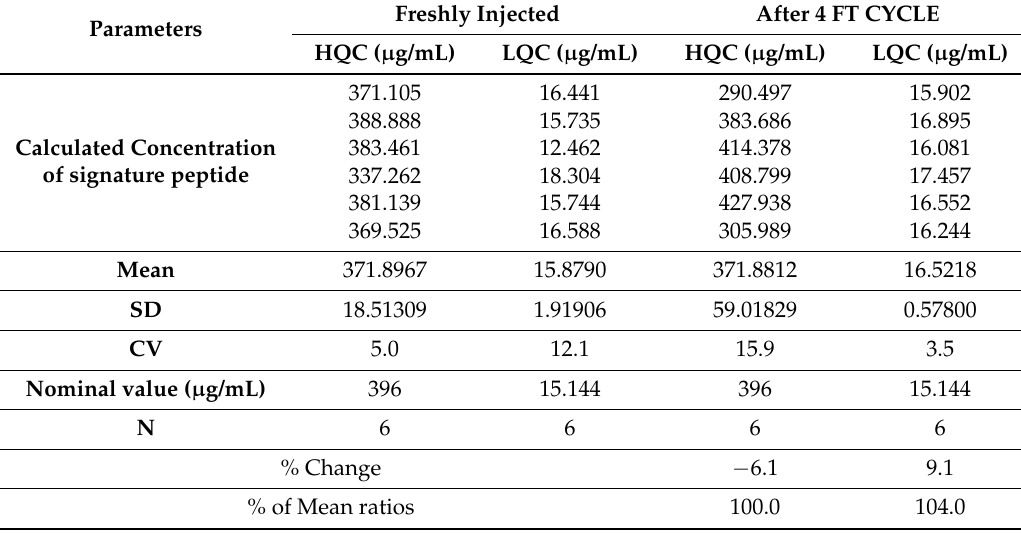
Table 5. Table demonstrates the stability data of trastuzumab signature peptide (IYPTNGYTR) after four freeze-thaw cycles of the human serum batch. Mean ratio; 100.0% and 104.0%and %change; − 6.1 and 9.1 was observed at HQC and LQC level, respectively. Here, n represents the number of sample analyzed for the stability experiment. (Acceptance criteria: %Change ≤ 15%; % Mean ratio 90%–110%, %CV ≤